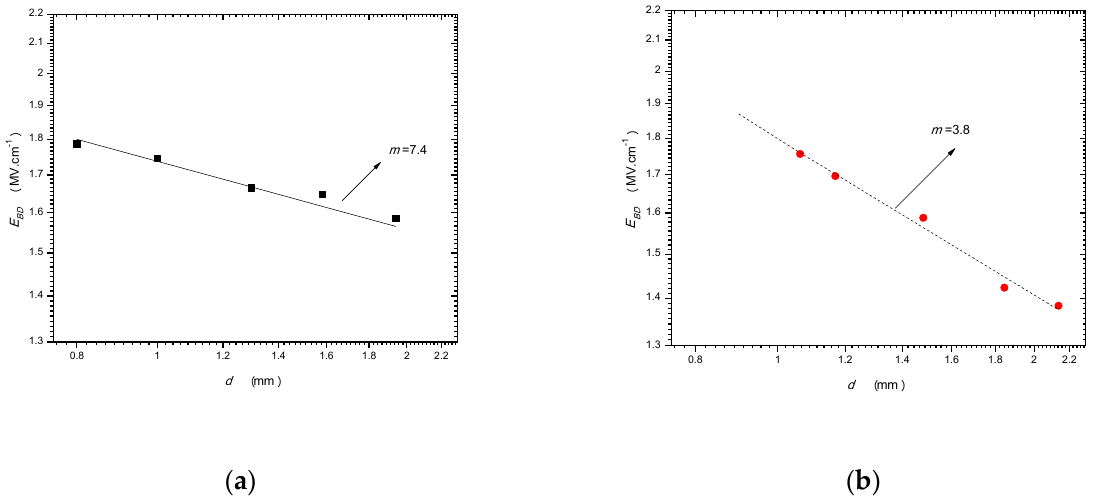
Figure 13. Fitting of different groups of E BD v.s. d data from two types of PMMA samples. ( a ) Pure PMMA; ( b ) porous PMMA.